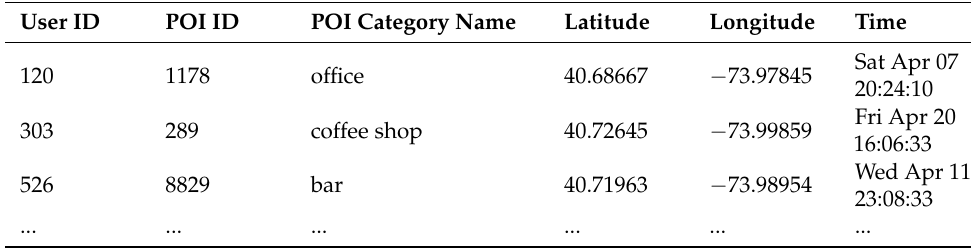
Table 1. check-in data on